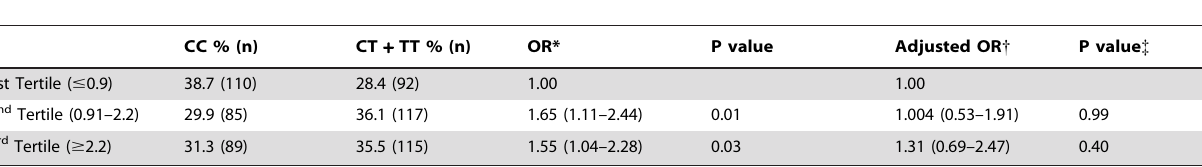
CC % (n) CT + TT % (n) OR* P value Adjusted OR { P value { 1st Tertile ( #